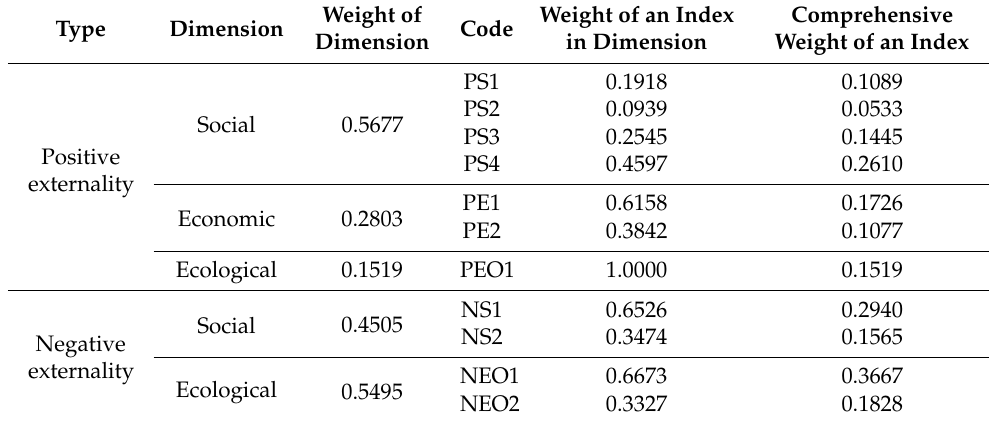
Table 4. Weights of the externality